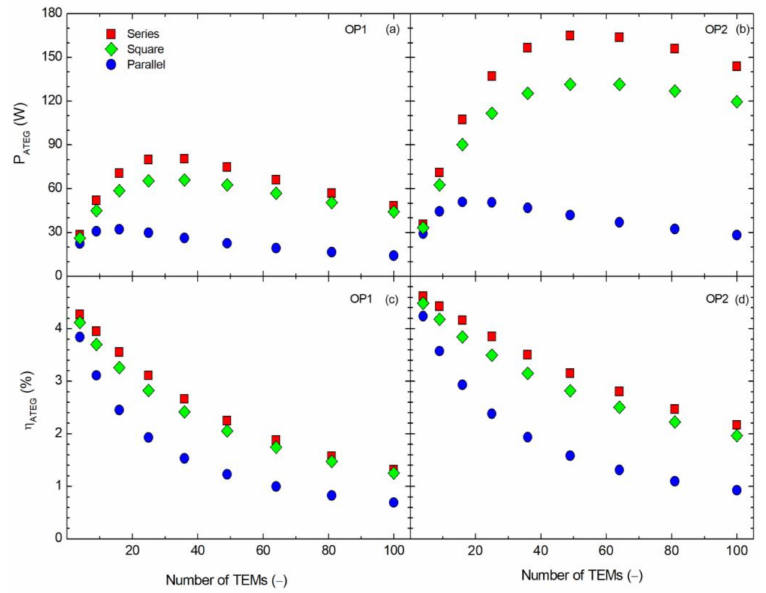
Figure 6. ATEG output power P ATEG and ATEG energy conversion efficiency η ATEG as a function of the number of TEMs in an ATEG for operating points #1 and #2, using series, square and parallel configurations. ( a ) P ATEG and OP1, ( b ) P ATEG and OP2, ( c ) η ATEG and OP1, ( d ) η ATEG and OP2.